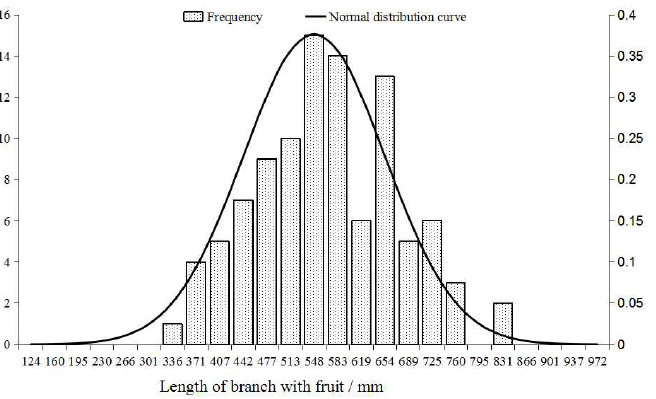
Figure 5. Length distribution of fruiting branches. The measured data show that the top diameter of the fruiting branches is 47.06% to 61.76% of the base diameter. Figure 6 shows the size distribution of the base and top diameters of fruit branches.